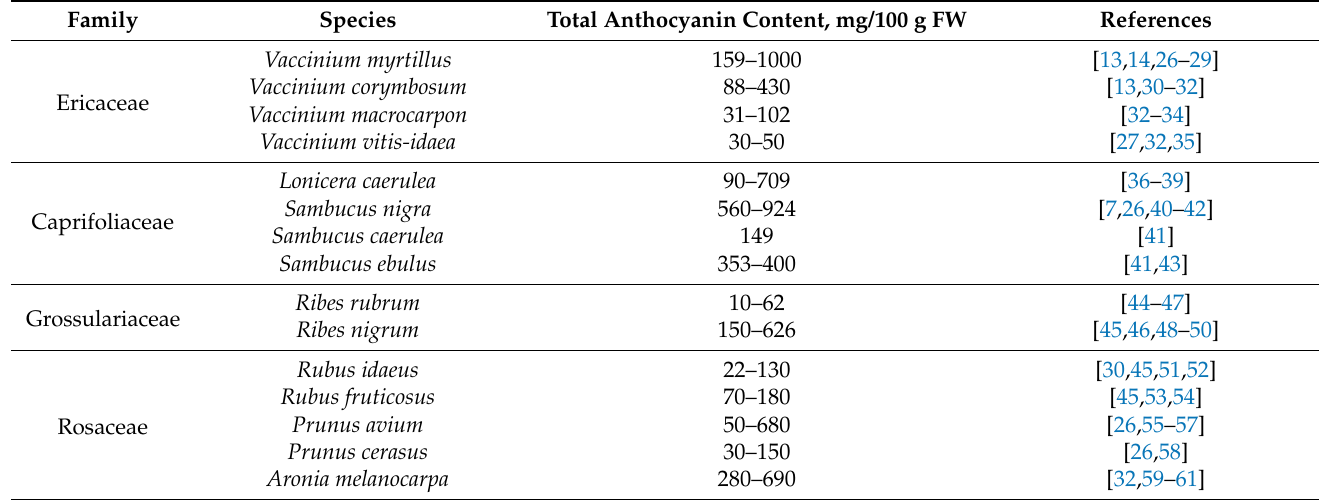
Table 1. Total anthocyanin content in various fruits, expressed in mg/100 g fresh weight (FW).